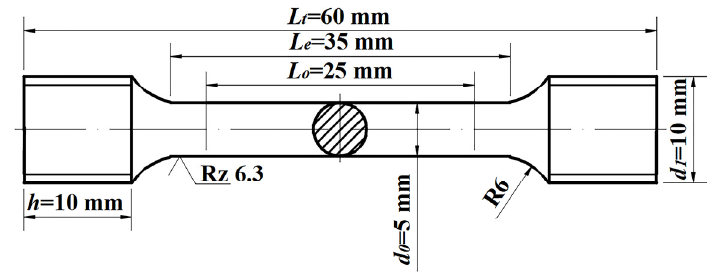
Figure 2. The shape of the mechanical properties test